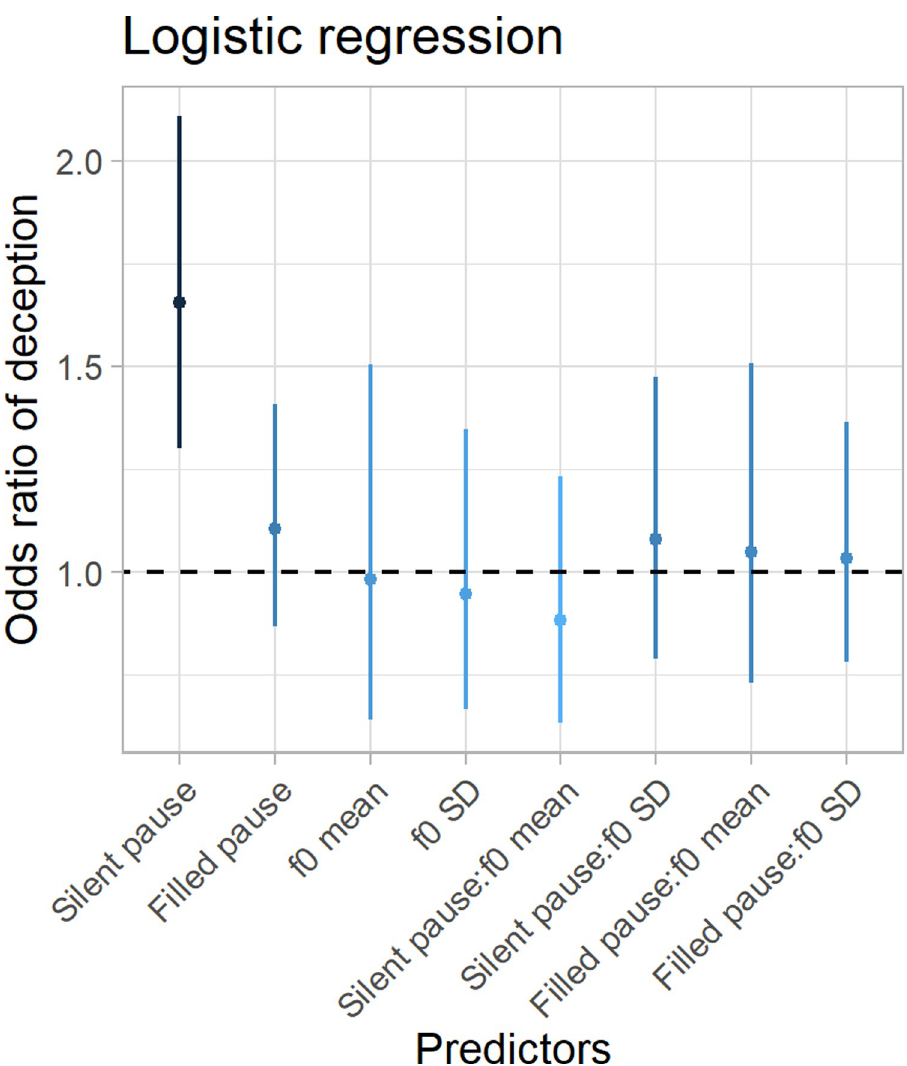
Fig 3. Estimates from logistical regression. The y-axis plots the odds-ratio: The increase in the odds that a statement is deceptive for every increase of 1 SD in each predictor variable. A 1 SD increase in the mean duration of silent pauses indicates that a statement has 1.66 times the odds of being deceptive. The x-axis reports all predictors that were included in the logistical regression model with interactions indicated by full colons (:). Line ranges indicate 95% confidence